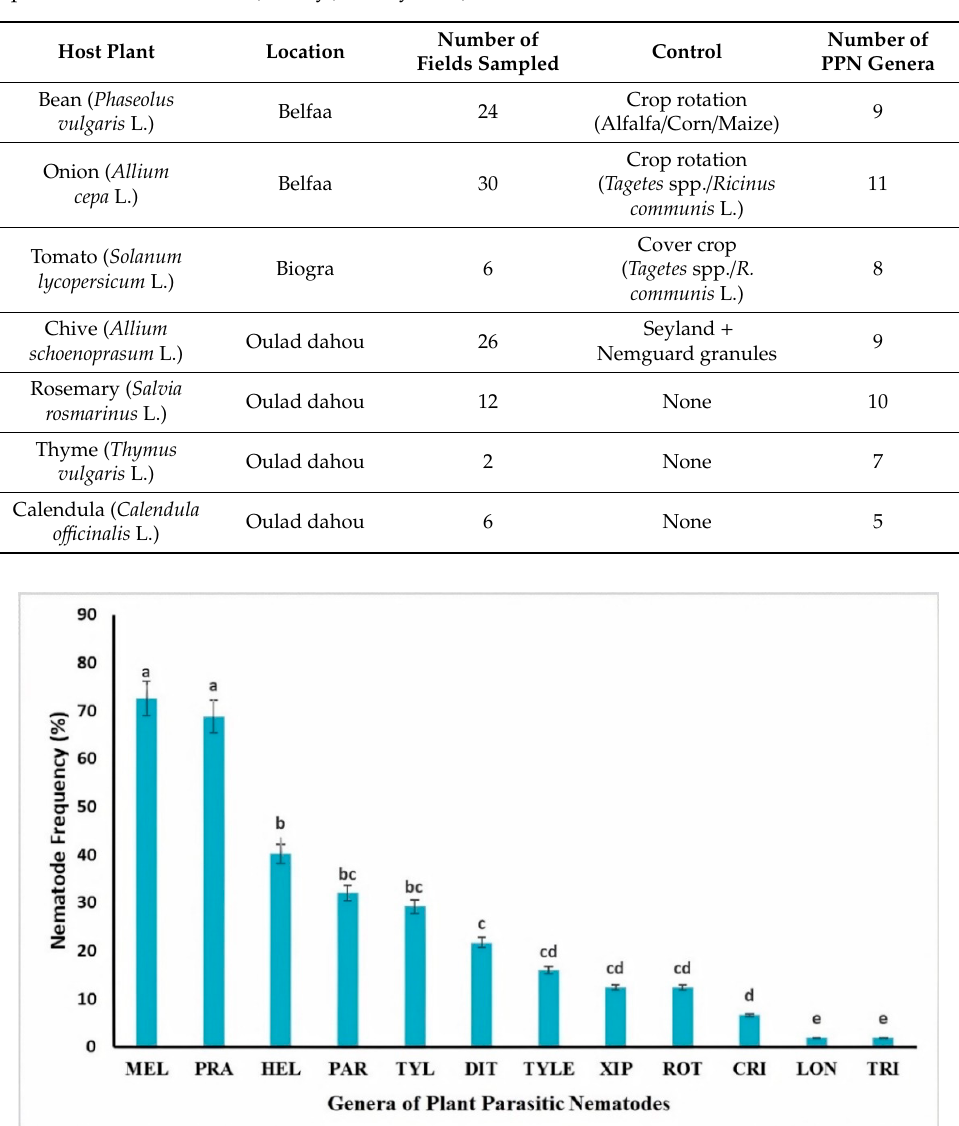
Table 2. The occurrence of plant parasitic nematodes in samples from fields with organically grown crops in Southern Morocco (survey January 2019).